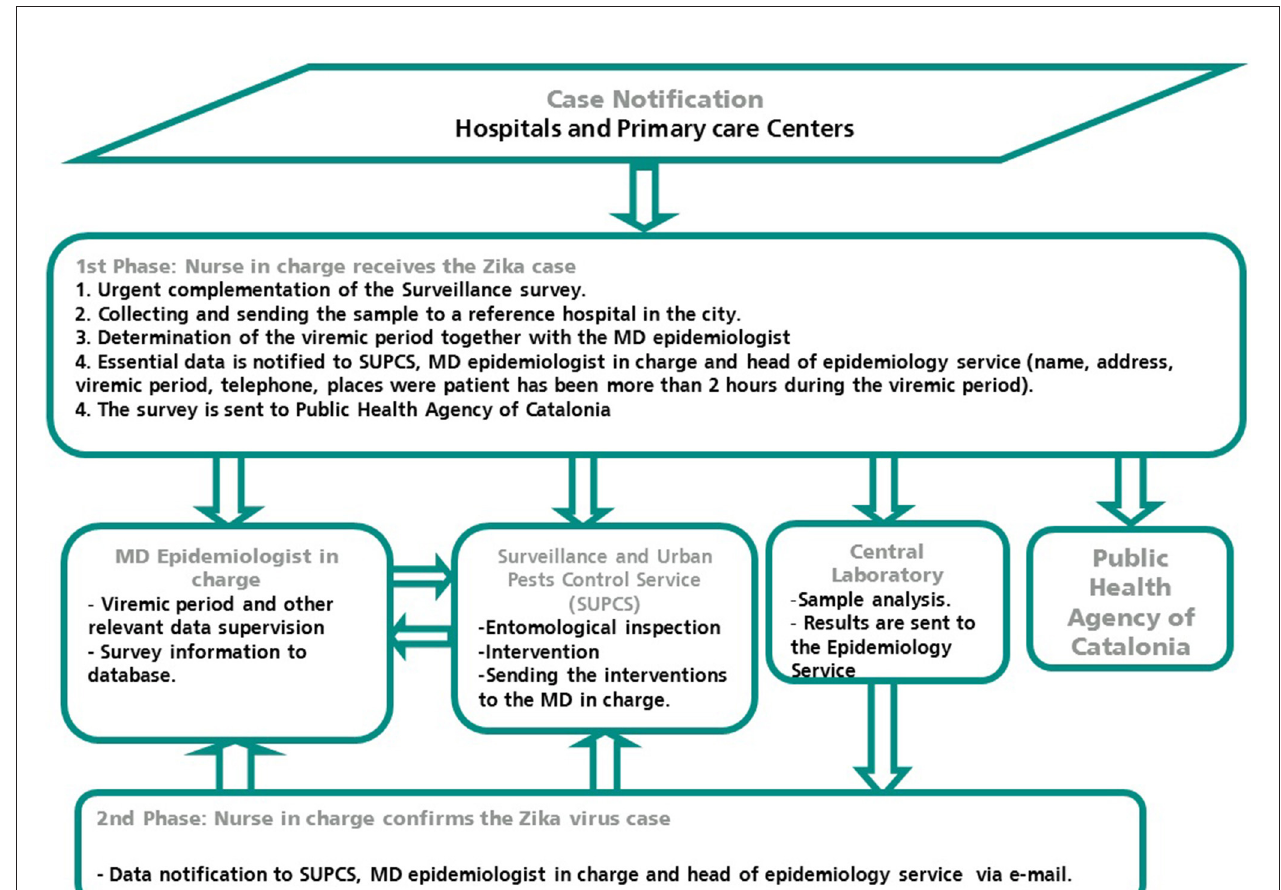
FIGURE 1 | Coordination diagram from notification of a case of ZIKV infection to the intervention of the entomologist in the city of Barcelona.